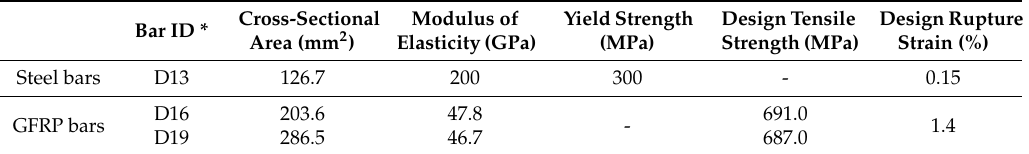
Table 1. Mechanical properties of